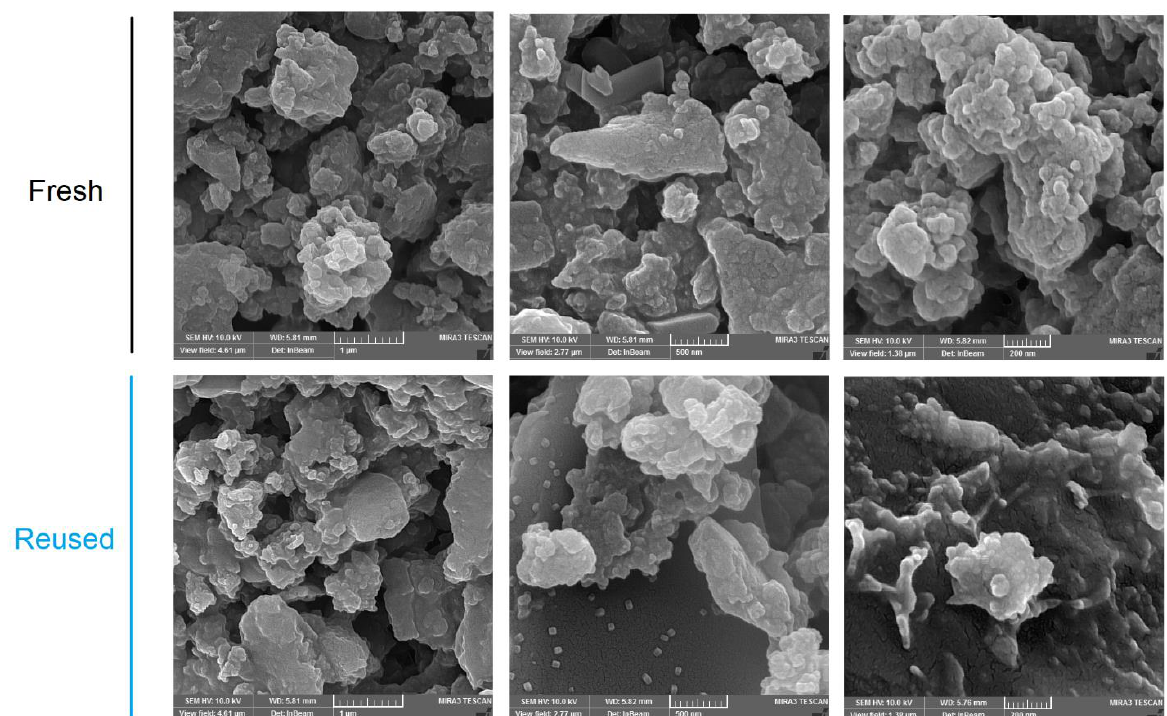
Figure 1. FESEM images of the resulting fresh and reused polymer.